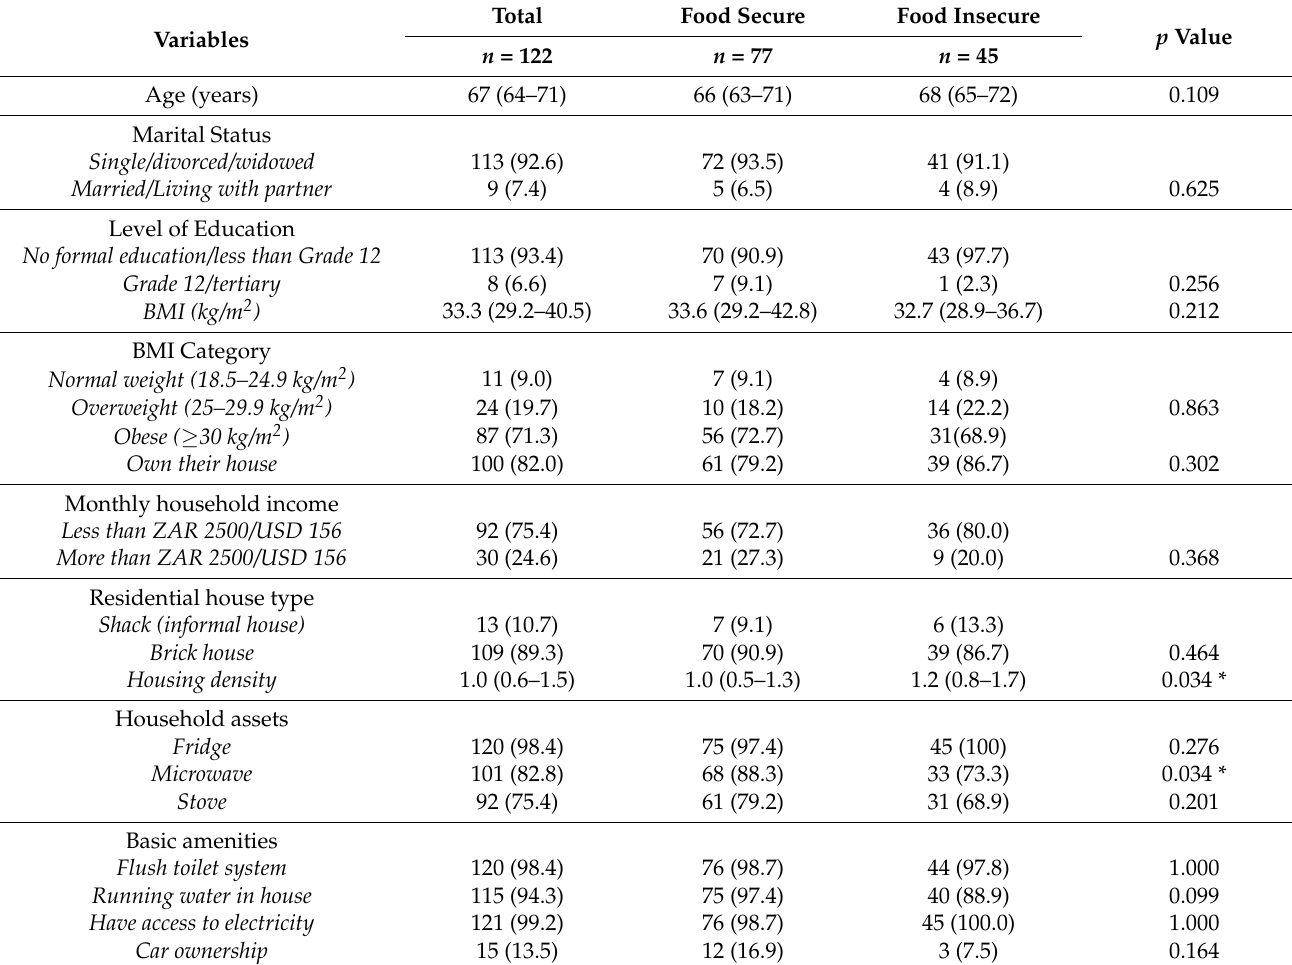
Table 1. Participant and household